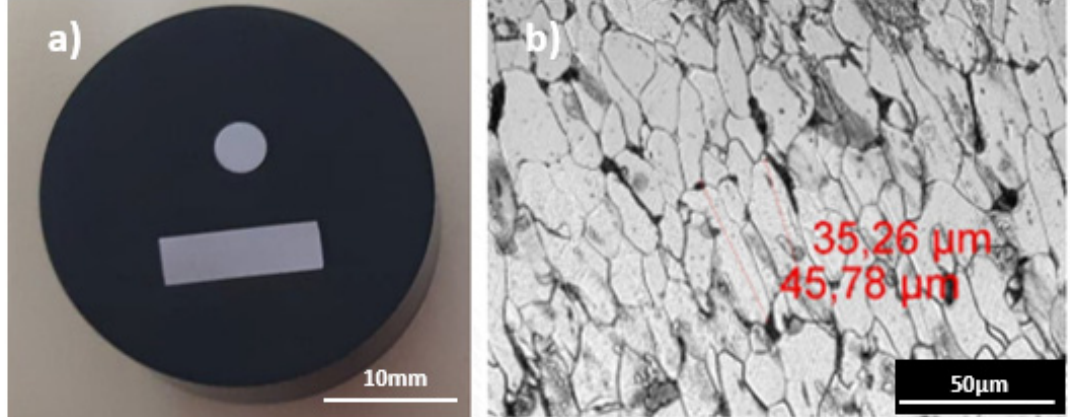
Figure 4. ( a ) Wire longitudinal and cross section encapsulated in Bakelite and polished. ( b ) Microstructure and grain size of the samples studied. Remark: Decimal separator in these images is "," instead of ".".